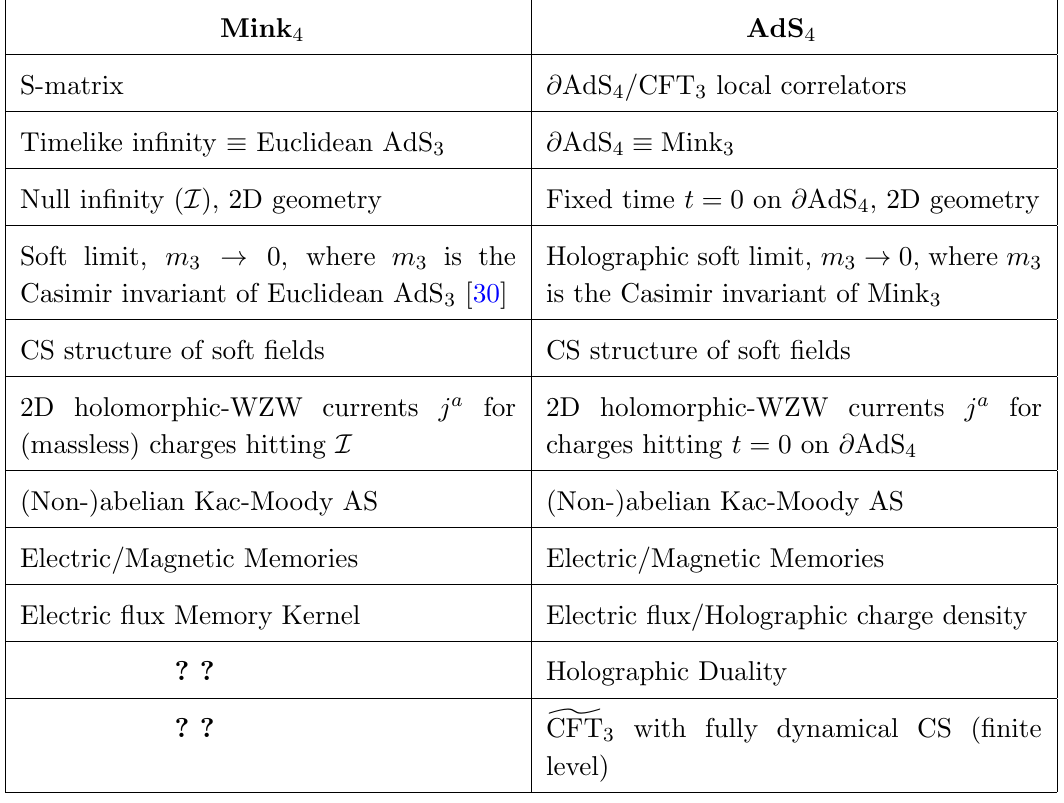
Table 1. The parallel developments between Mink 4 and AdS 4 gauge dynamics, their soft limits and associated in(cid:12)nite-dimensional KM asymptotic symmetries. AdS/CFT holography provides more of an explanatory structure in the case of AdS 4